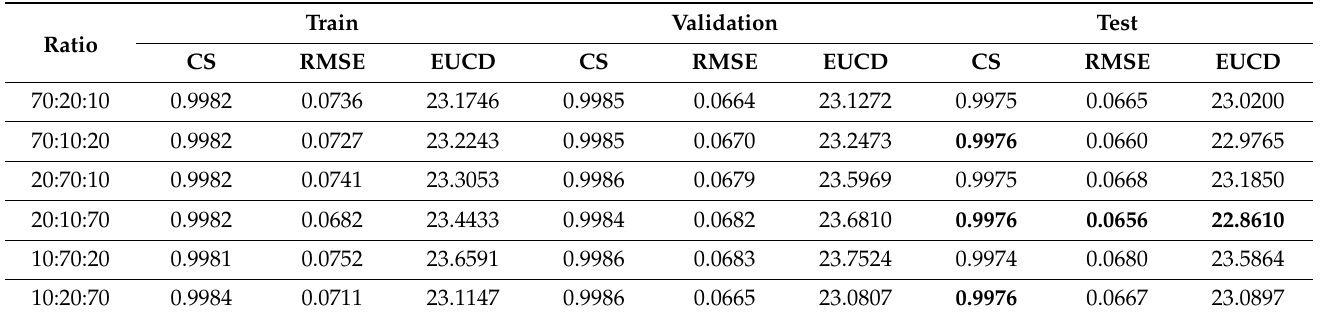
Table 2. Cross validation with reference